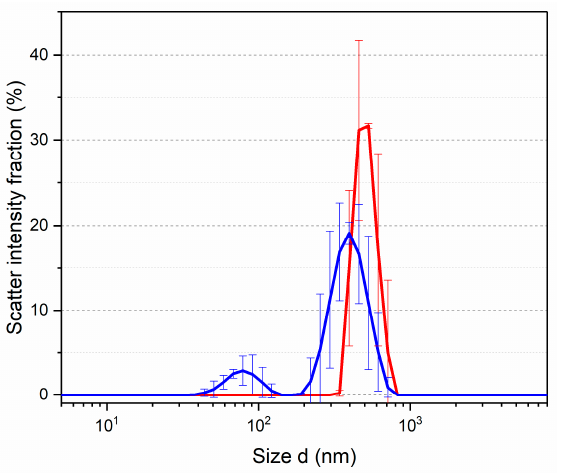
Figure 2. Particle size distribution in solutions of synthesized Zn(Met) 2 (red) and crystallized Zn(Met) 2 (SO 4 ) x ·nH 2 O (blue) complexes (n = 3). Zn(Met) · nH 2 (SO 4 ) x 2 O (blue) complexes (n =